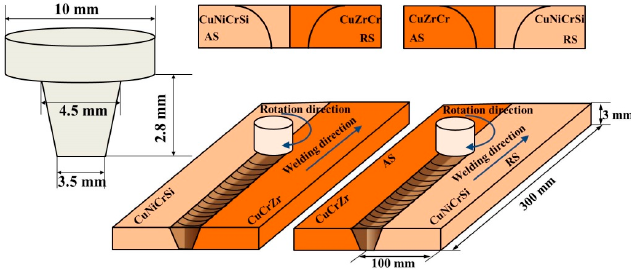
Figure 1. The schematic representation of the friction-stir-welding process and dimensions of the friction stir welding (FSW) tool.